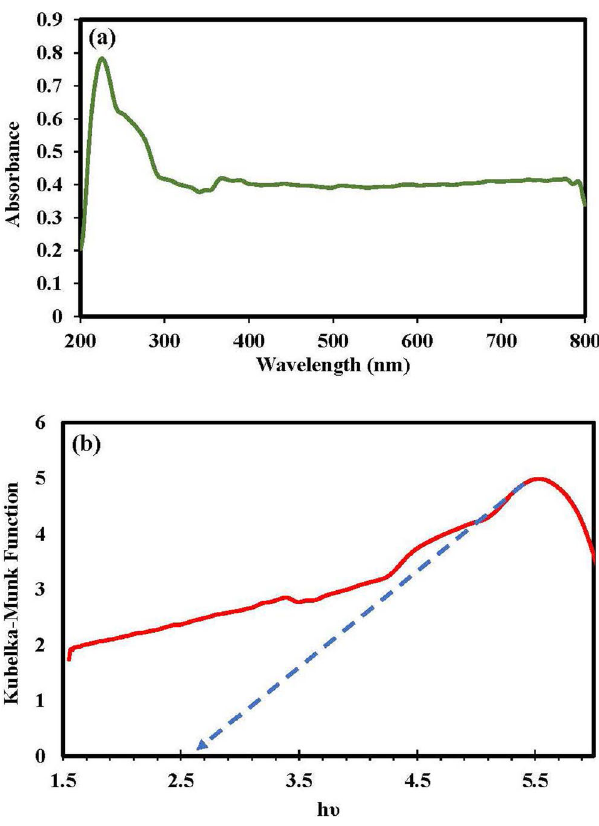
Fig. 3 Ultraviolet/Visible (UV-Vis) spectrum and Diffuse re fl ec- tance spectroscopy (DRS) of CdSe nanoparticles. a UV-Vis and b DRS.